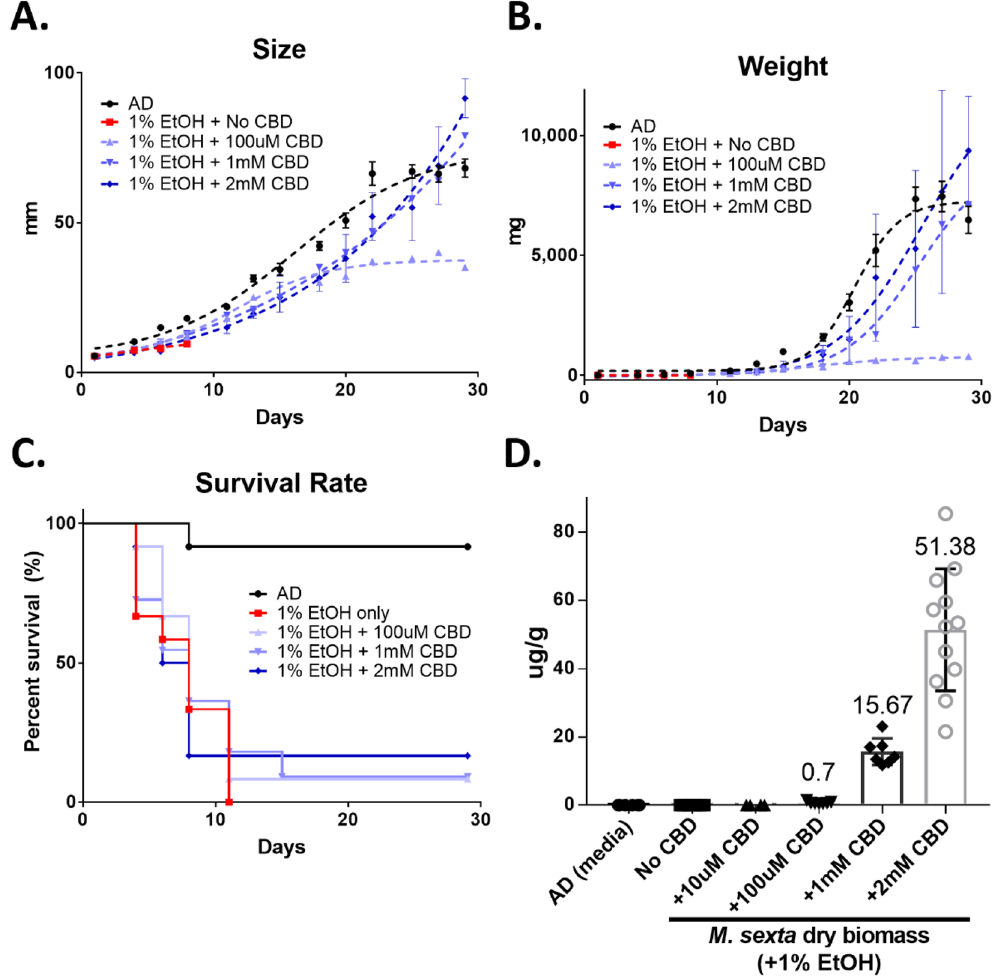
Figure 4. The growth and survival rate of M . sexta larvae reared on AD containing 1% EtOH with different CBD concentrations, ranging from 100 μ M to 2 mM CBD. Comparison of size ( A ), weight ( B ), and survival rate ( C ) of larvae are shown. The larval survival rate was analyzed by Mantel-Cox test (n = 11~12, p < 0.05). ( D ) CBD accumulation in M . sexta larvae ( μ g of CBD/g of dry weight) when fed on different media. AD; artificial diet as negative